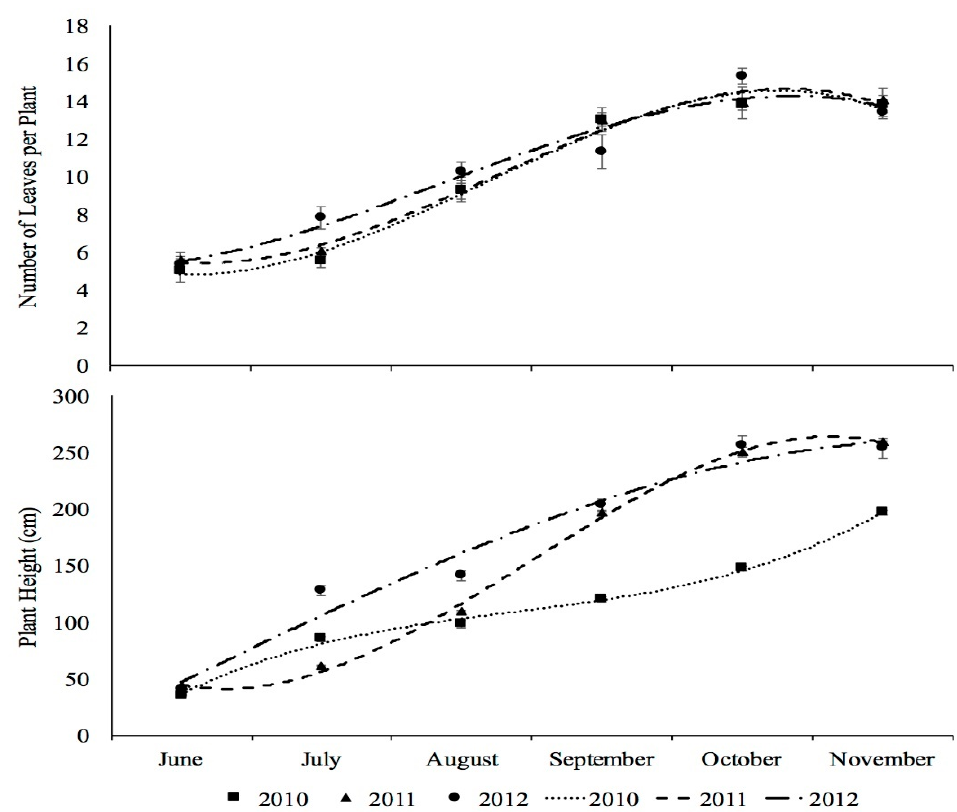
Figure 2. Change in leaf number (upper panel) and plant height (lower panel) across the three years 2010–2012 (growth years 4 to 6) of M. × giganteus growing in the Lower Silesia Region of Poland. Values were estimated from 10 randomly selected stems within a randomly chosen 0.25 m 2 to produce a plot average which was then averaged across 4 replicated plots (legend indicates growth year; bar is standard error n = 4; lines represent fit of 3rd order polynomial).